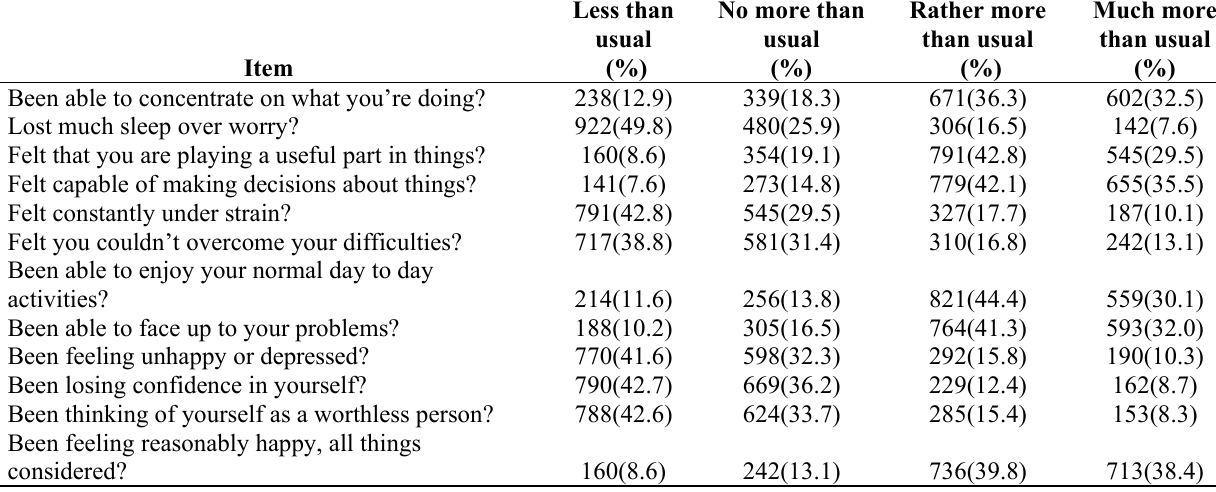
Table S1: Health Benefits of Green Infrastructure